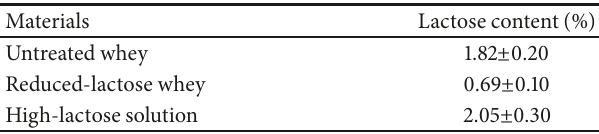
Table 1: Lactose content in untreated whey, reduced-lactose whey, and high-lactose